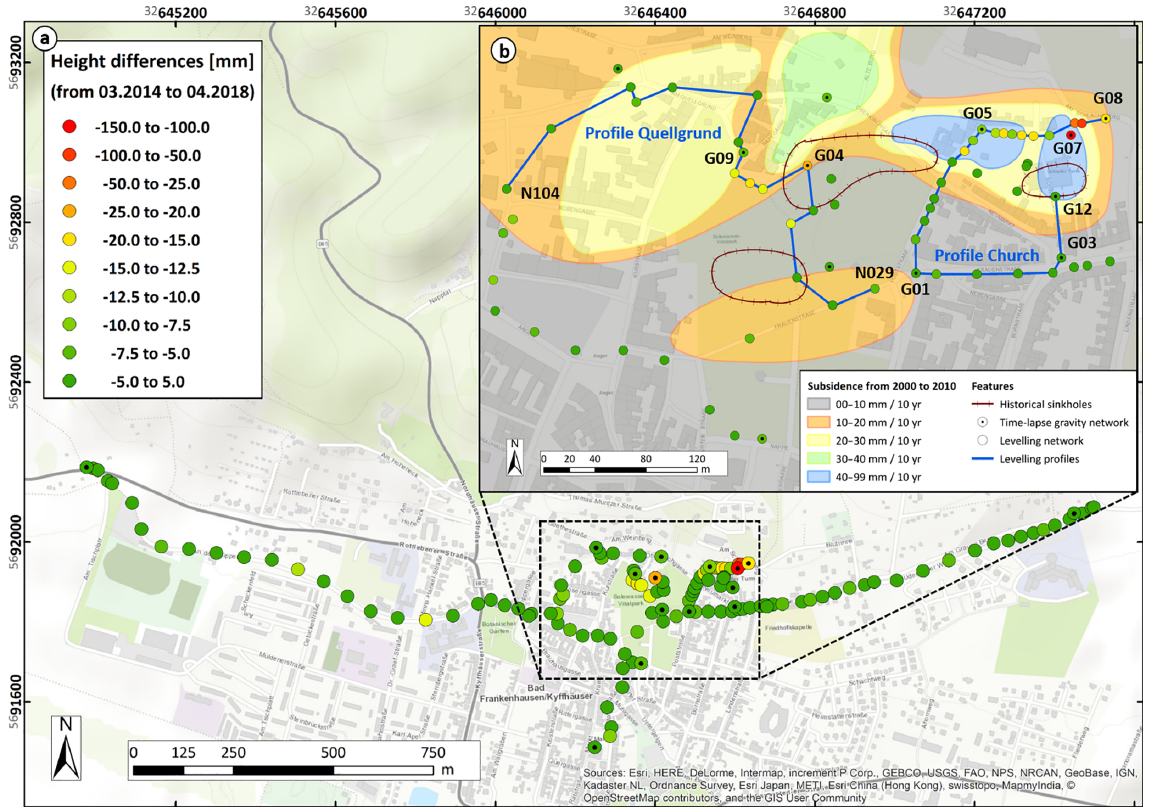
Figure 6. Levelling results over 4 years. (a) Measurement network in BF showing colour-coded height changes between April 2018 and the reference measurement in March 2014. Additional black points mark the gravimetric network. (b) Height variations over 4 years in the medieval centre of BF, with up to − 121 . 7mm at point G07. They are compared to the location of historical sinkholes (brown polygons) and the levelling results obtained by Scholte (Glückauf Vermessung Sondershausen, unpublished data). The blue lines mark the current levelling profiles that show the time-variable development of subsidence in Fig. 7.